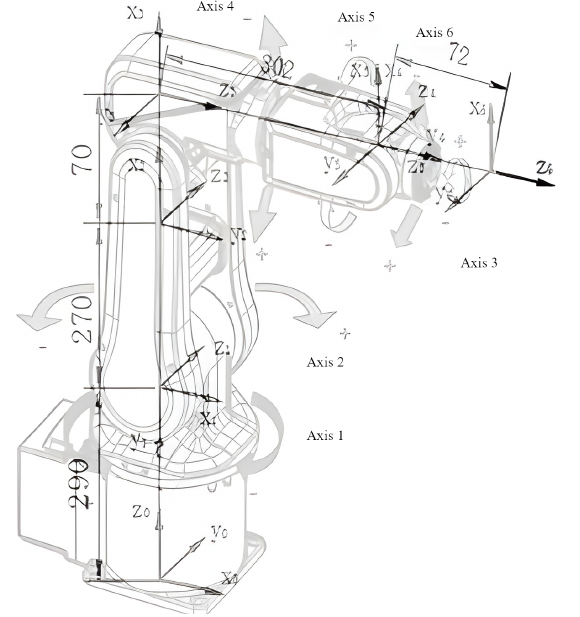
Figure 1. Simplified kinematic schematic of the ABB IRB 120 robot, with the associated D-H orthonor- mal coordinate systems.